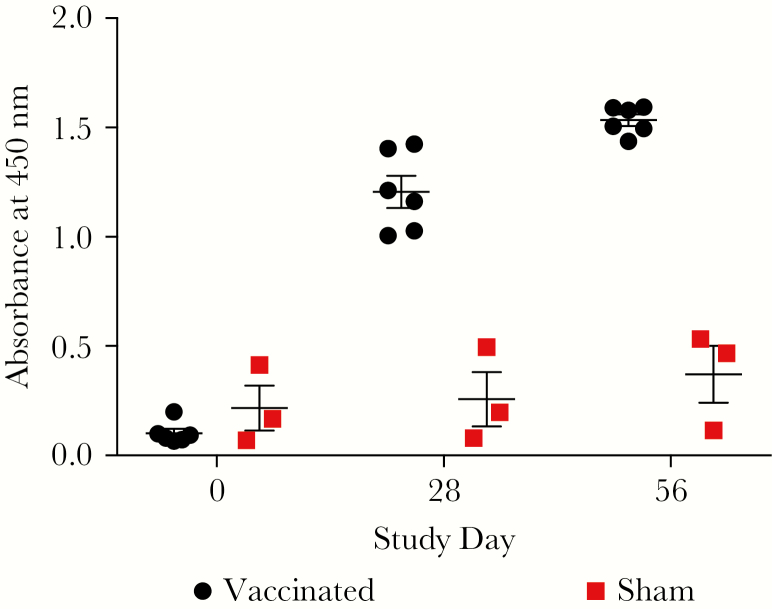
Anti-Chikungunya virus immunoglobulin titers in sera collected on days 0, 28, and 56 of the study as assayed by enzyme-linked immunosorbent assay. Sera yielding absorbance values that exceeded the means of negative control sera by more than 2 standard deviations were considered positive. The mean absorbance of the negative control sera was 0.08 at 450 nm. Error bars denote standard error.